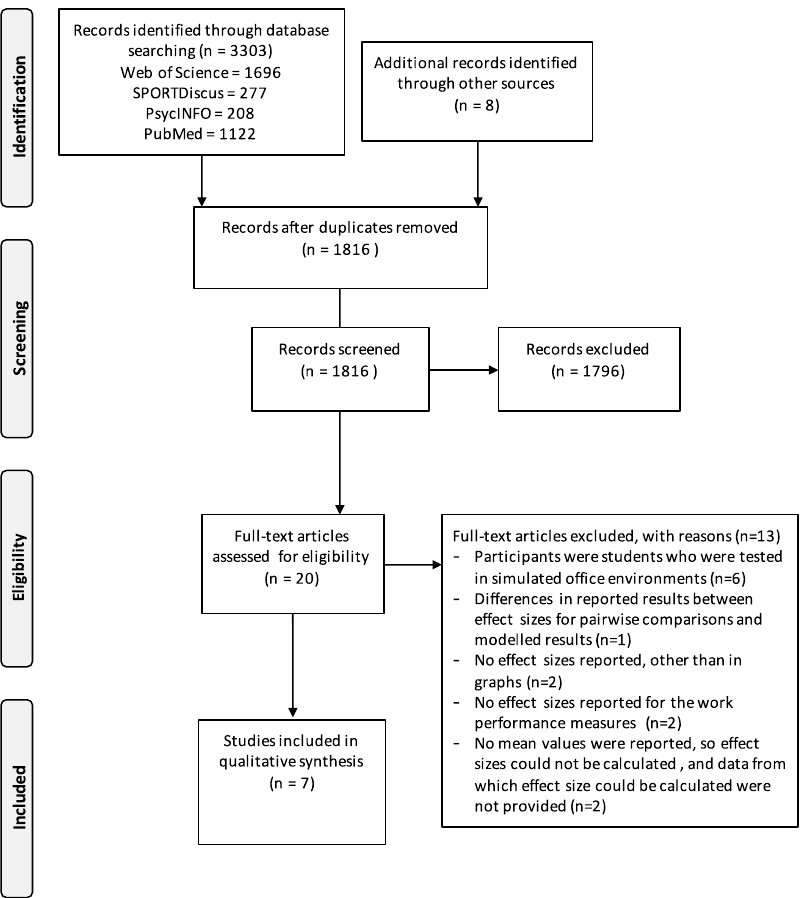
Figure 1. Preferred Reporting Items for Systematic Review and Meta-Analyses (PRISMA) flow chart of study selection [41].